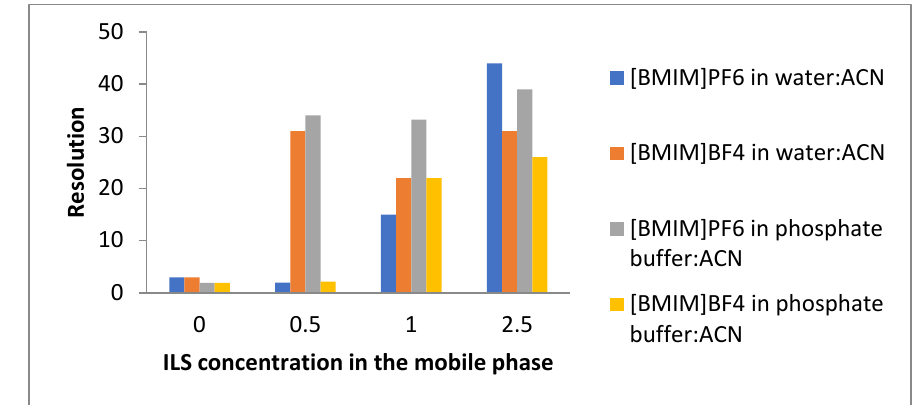
Figure 6. Effect of IL concentration on the resolution of the target compounds by using different mobile phases .